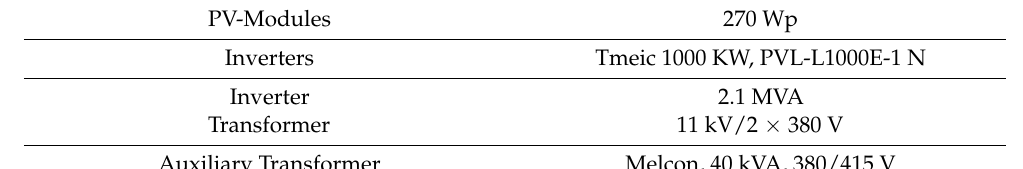
Table 2. Technical Description.